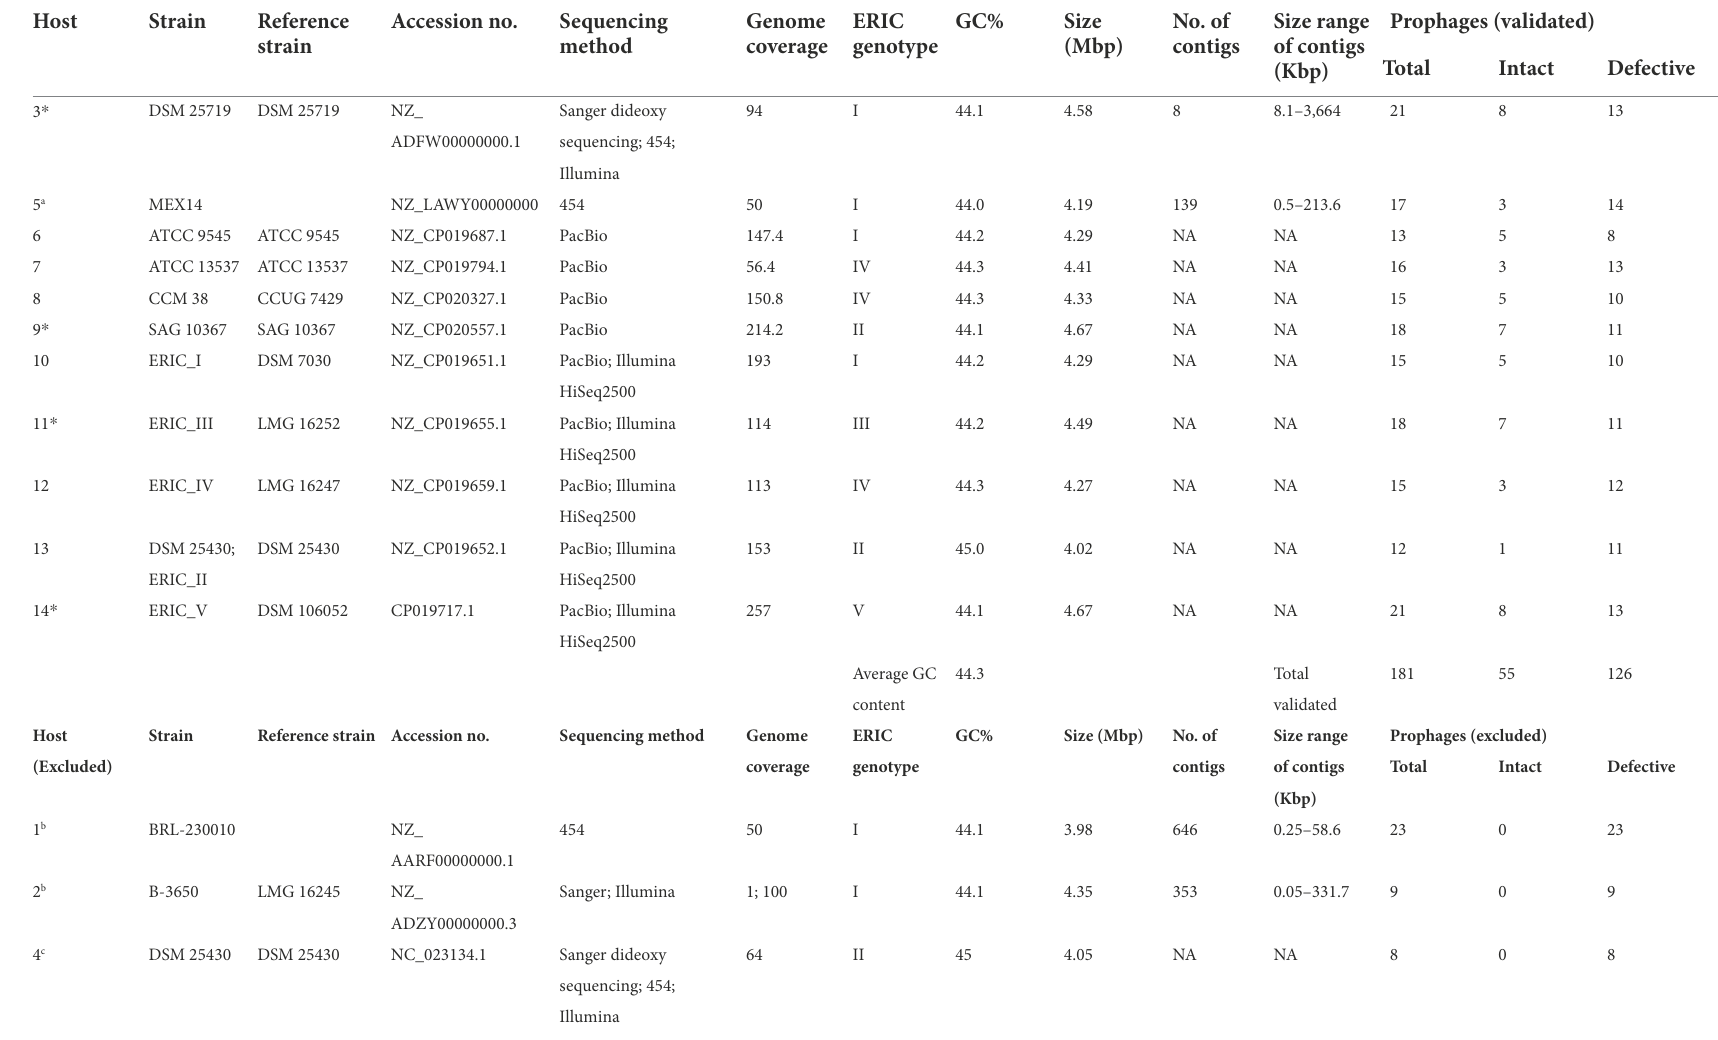
TABLE 1 Paenibacillus larvae strains and respective reference name, accession number, genome sequencing method and coverage, genotype classification, GC content, genome size, number of contigs, and respective